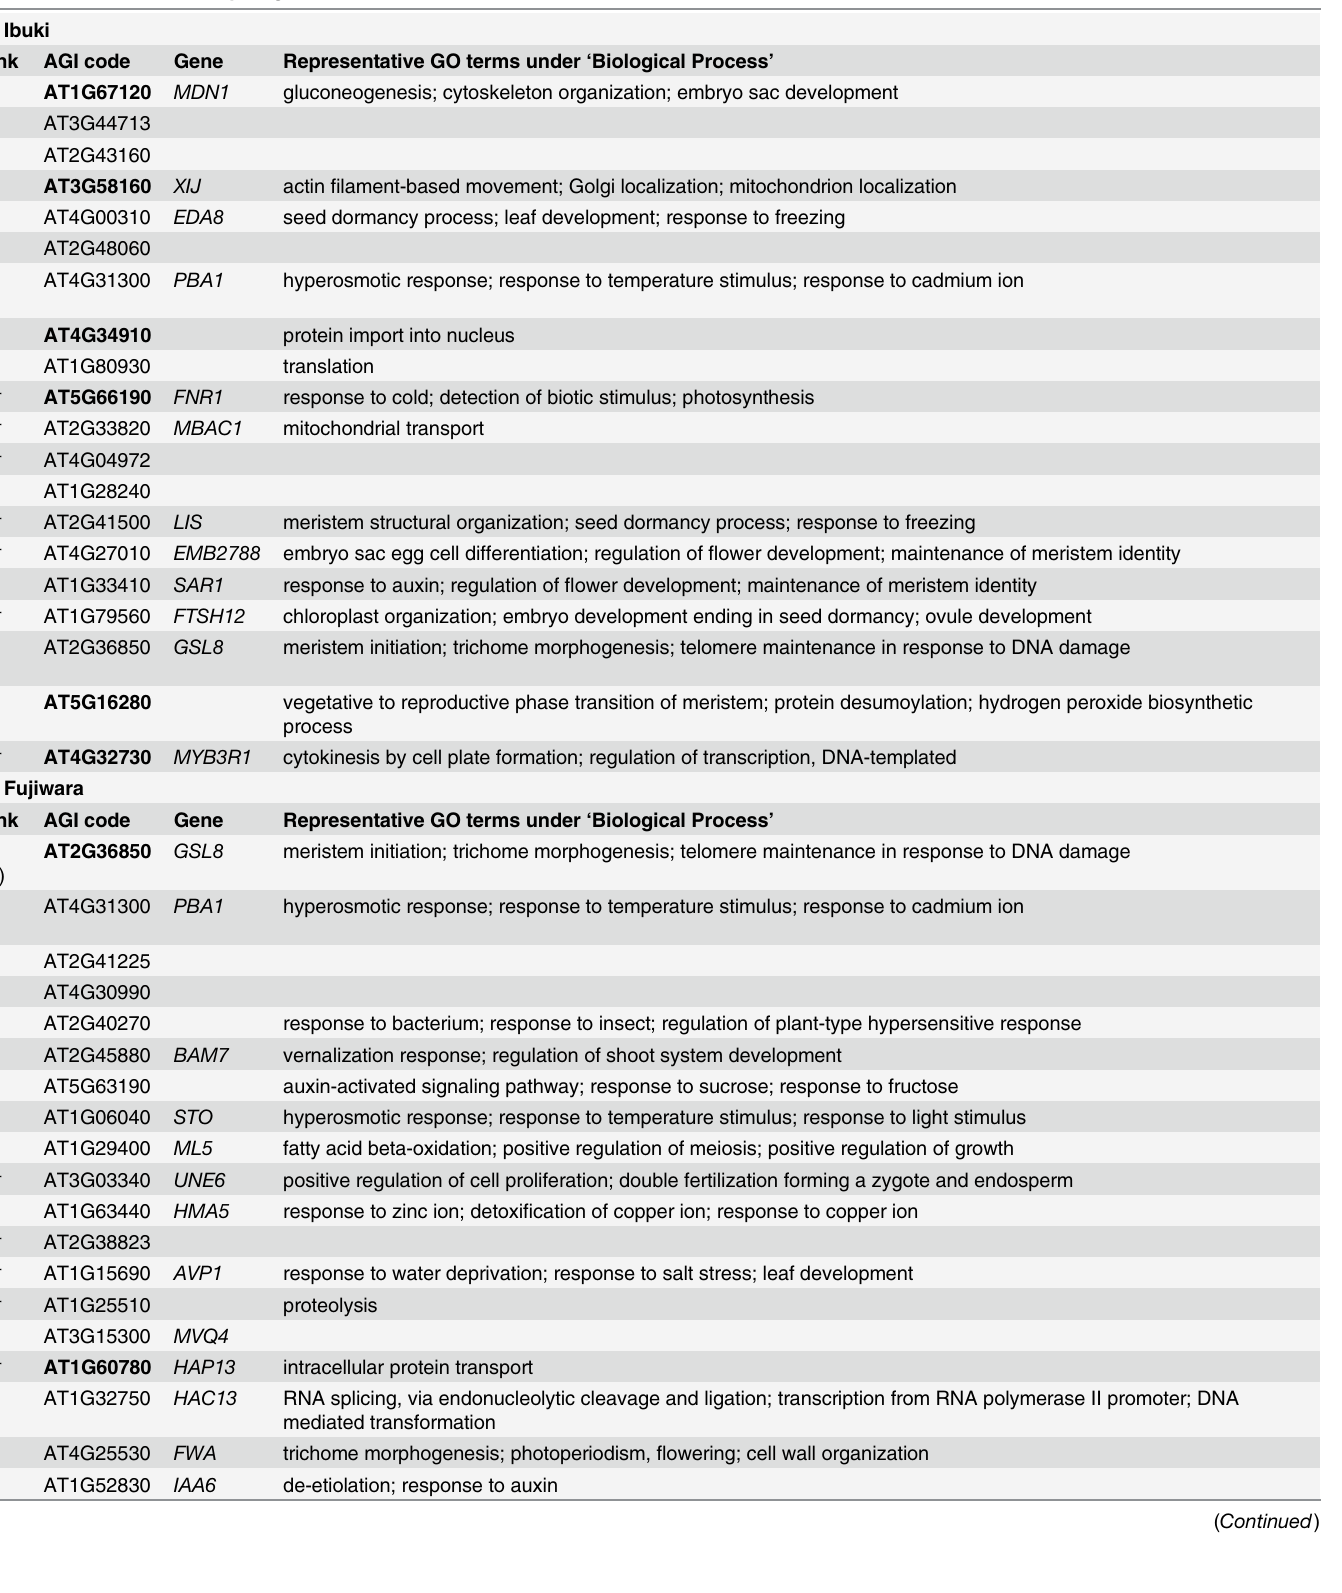
Table 2. Genes within the top 20 genomic islands from each